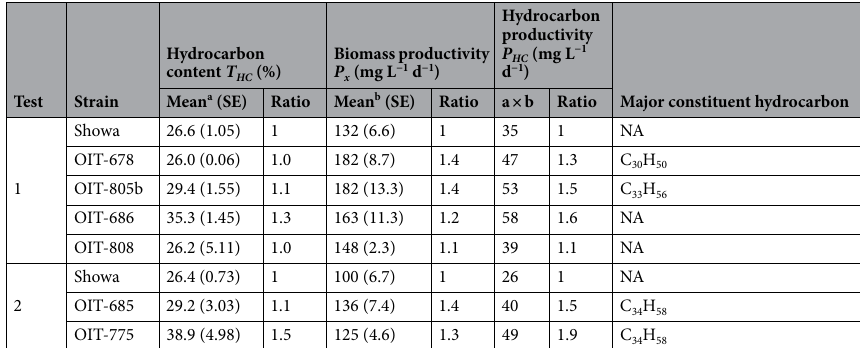
Table 3. Hydrocarbon content, productivity, and major constituent of wild fast-growing Botryococcus braunii strains. Results of two independent experiments, each of which uses Showa strain as a standard, are shown. Ratios of mean values of wild strains to that of the standard strain Showa are also indicated. SE = Standard Error ( n = 6), NA = Not